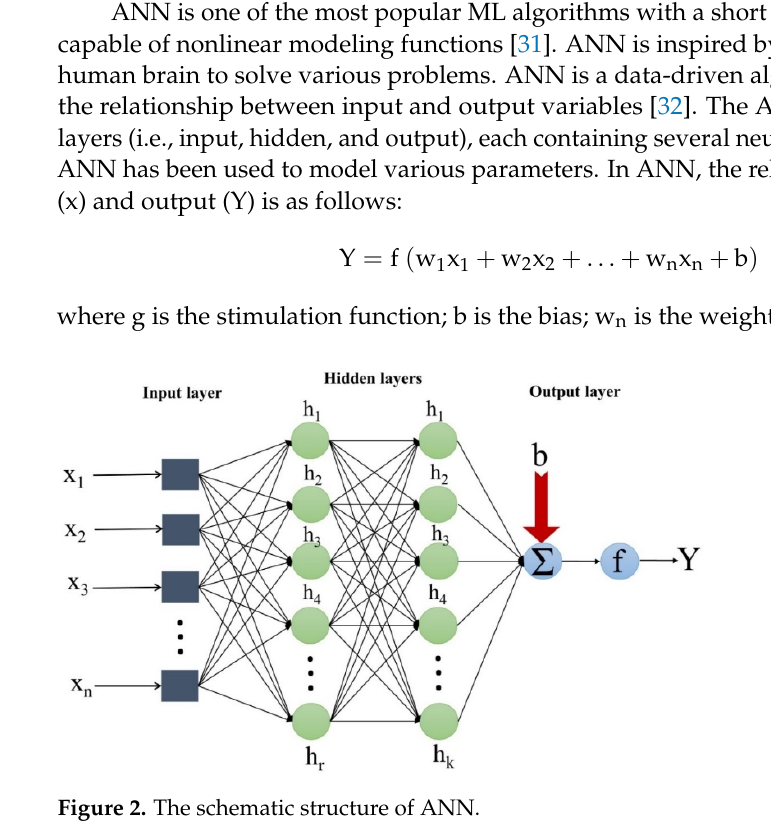
Figure 2. The schematic structure of ANN.